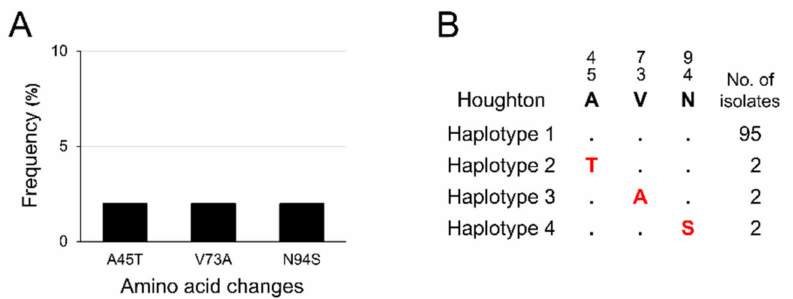
Figure 2. Amino acid sequence polymorphism of etsag1 in Korean E. tenella isolates. ( A ) Amino acid changes. Three different amino acid changes were detected in Korean etsag1 . ( B ) Haplotype diversity. Four distinct haplotypes were identified in 101 Korean etsag1 sequences. The dots represent residues identical to the reference sequence of the Houghton strain (AJ586531.2). Amino acid changes at particular amino acid positions are indicated as red.